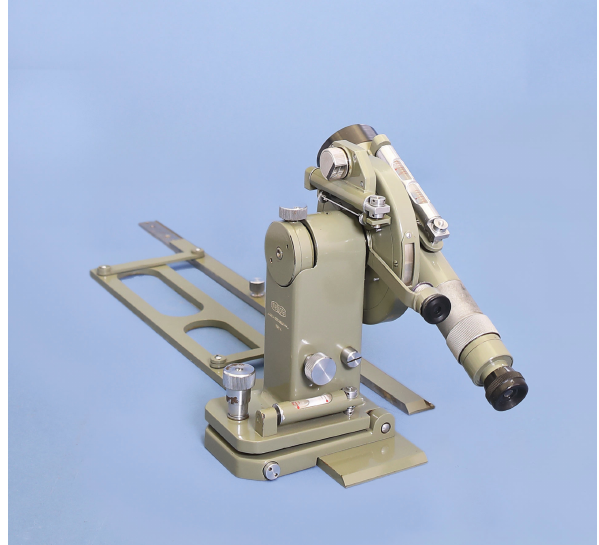
Figure 9. Eclimeter by Meopta company (photo supplied by https: